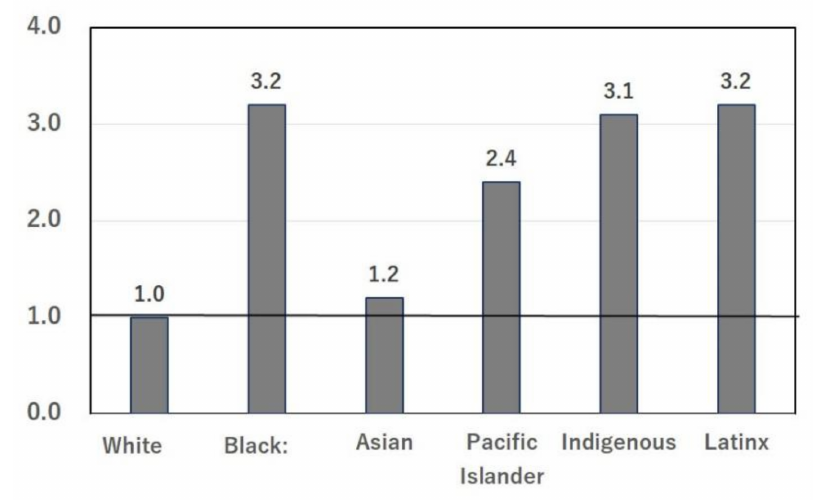
Figure 2. Deaths from COVID-19 according to ethnicity in the U.S. Numbers are relative to the number of Whites as 1. Data were obtained from a cross-sectional study: Centers for Disease Control and Prevention. COVID View. Key updates were for week 43, ending 24 October 2020. Accessed at www.cdc.gov/coronavirus/2019-ncov/covid-data/pdf/covidview-10-30-2020.pdf (accessed 10 December 2021).